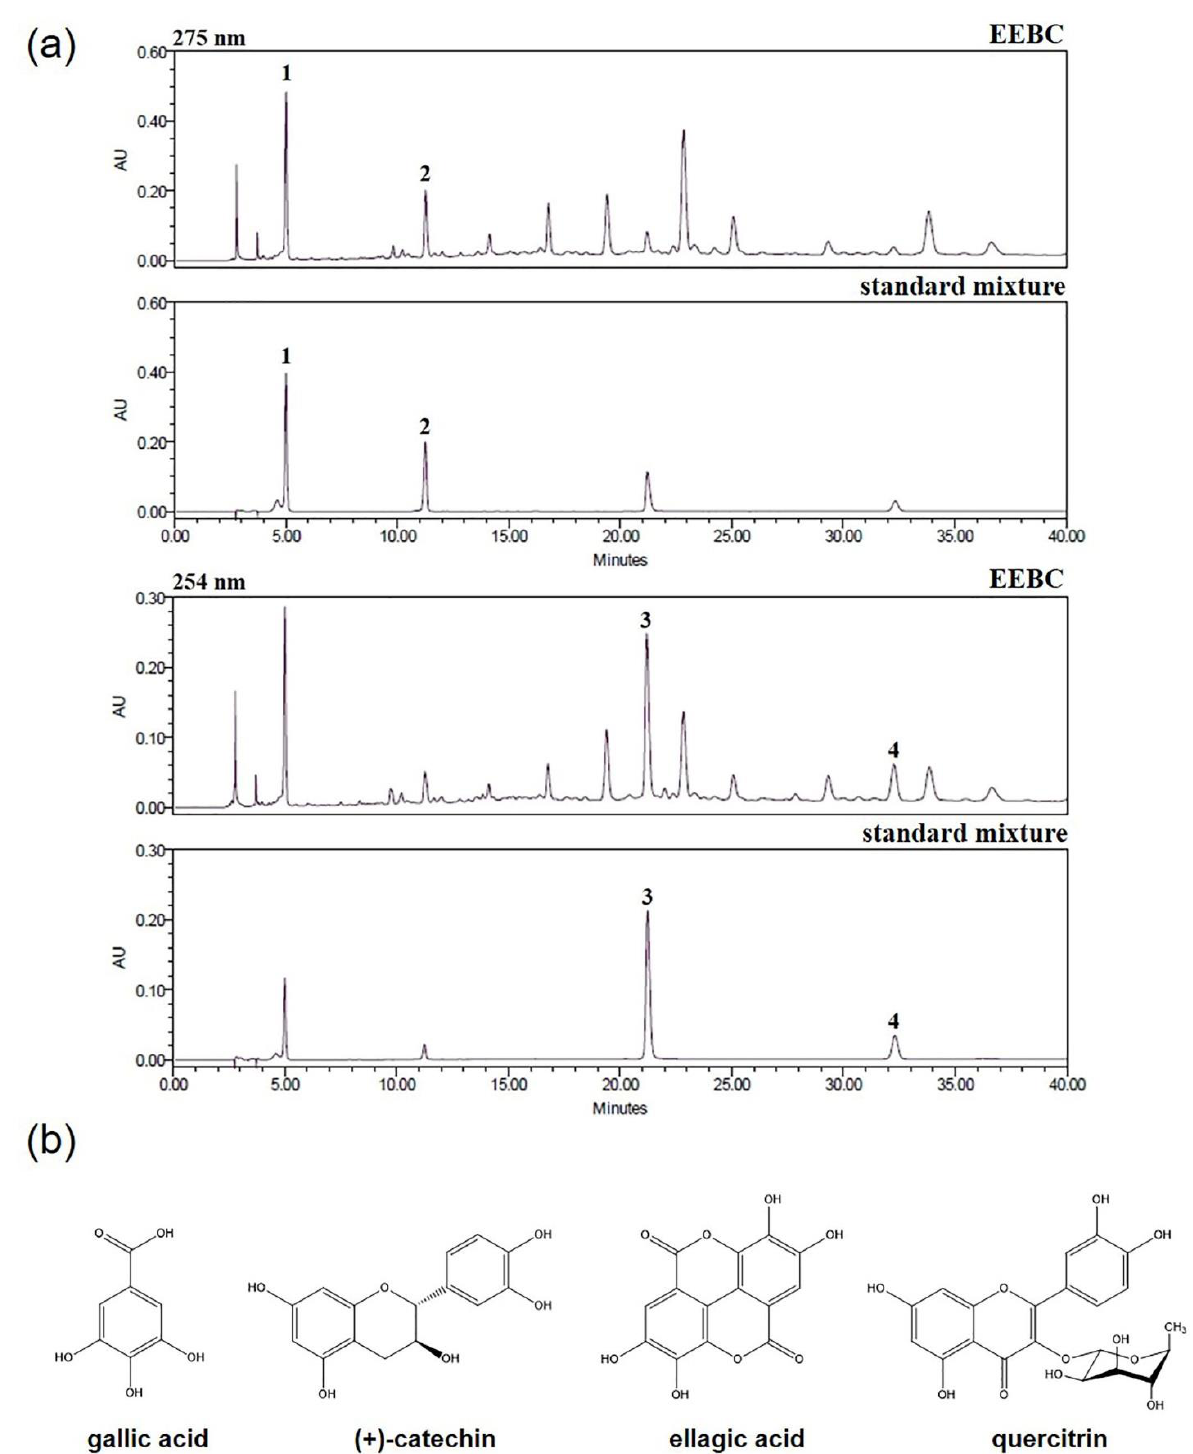
Figure 1. ( a ) HPLC chromatograms of ethanol extracts of B. coccinea branches (EEBC) and standard mixture at 275 and 254 nm. Gallic acid (1), (+)-catechin (2), ellagic acid (3), and quercitrin (4); ( b ) Chemical structures of the four marker compounds in B. coccinea . HPLC: high performance liquid chromatography. EEBC: ethanol extracts of B. coccinea branches. 2.2. Regression Equation, Linearity, Limits of Detection (LOD), and Limits of Quantification (LOQ) The linear relationships between the peak area ( y ) and concentration ( x , µg/mL) of each compound are represented by the regression equations ( y = a x + b) in Table 1. The